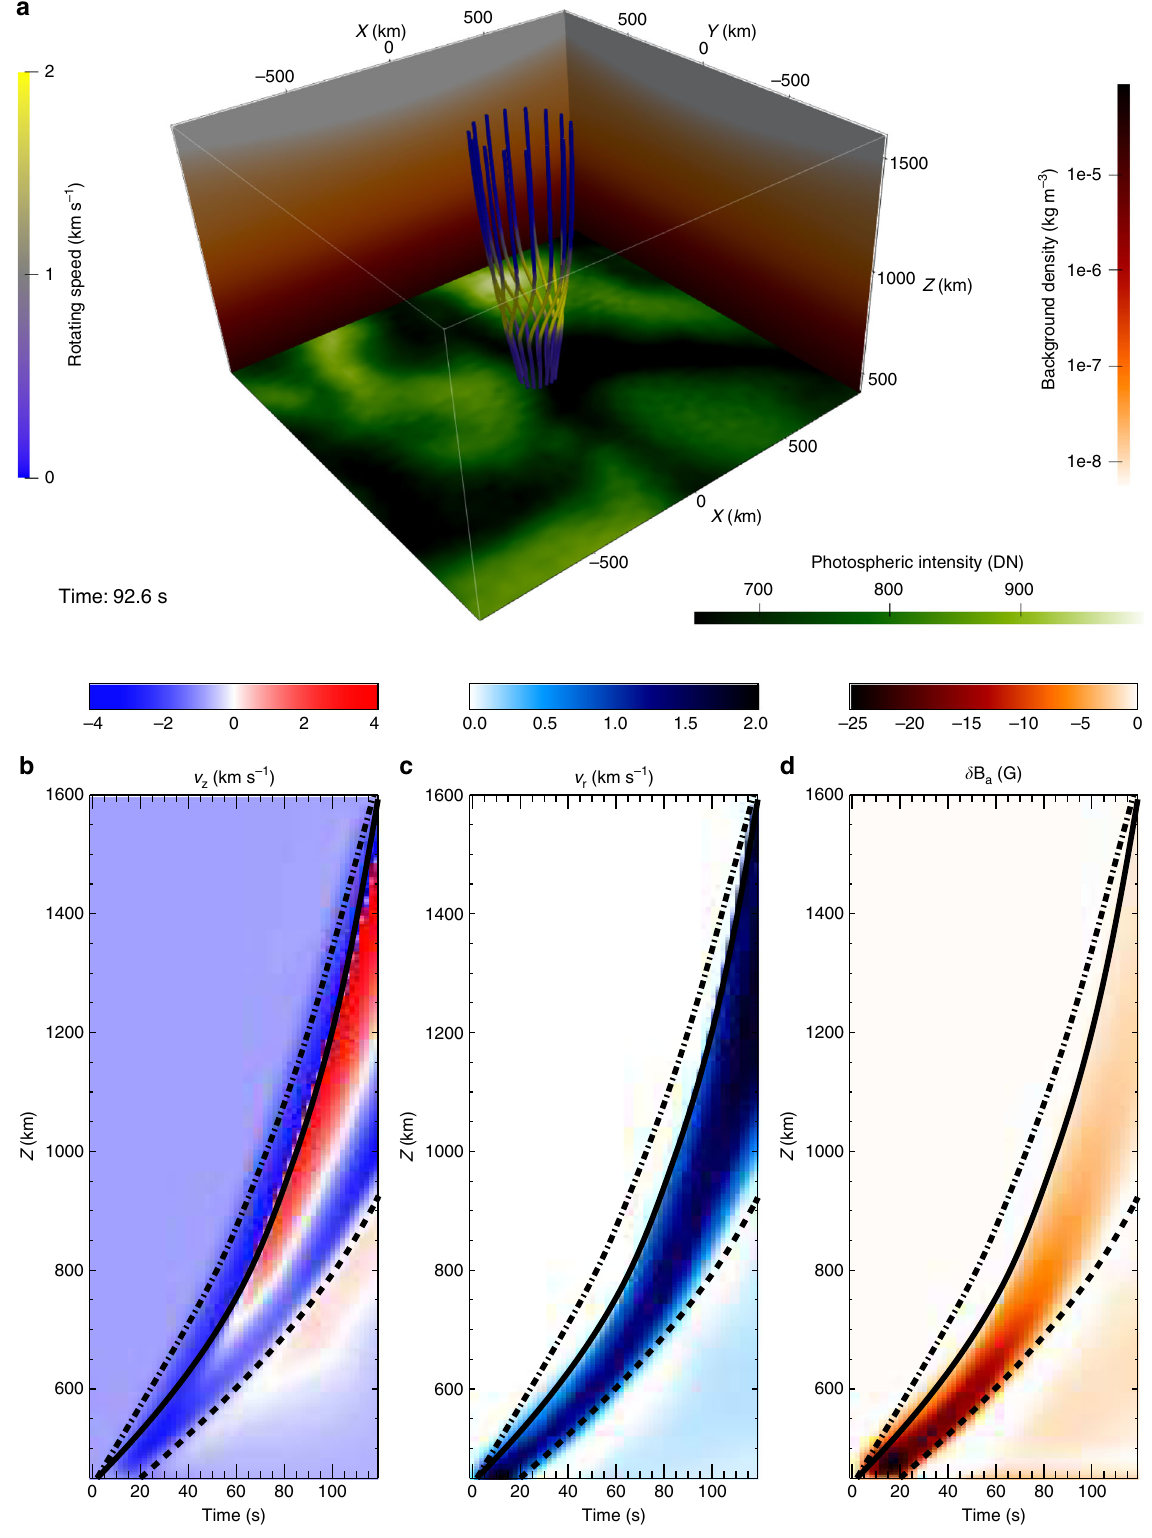
velocity perturbation shows that the pulse travels upward at three different local speeds: the sound speed (dash-dotted curve), the Alfvén speed (solid curve) and the tube speed (dashed curve). However, only the Alfvén pulse carries information of the rotational motion (panel c) and azimuthal magnetic fi eld